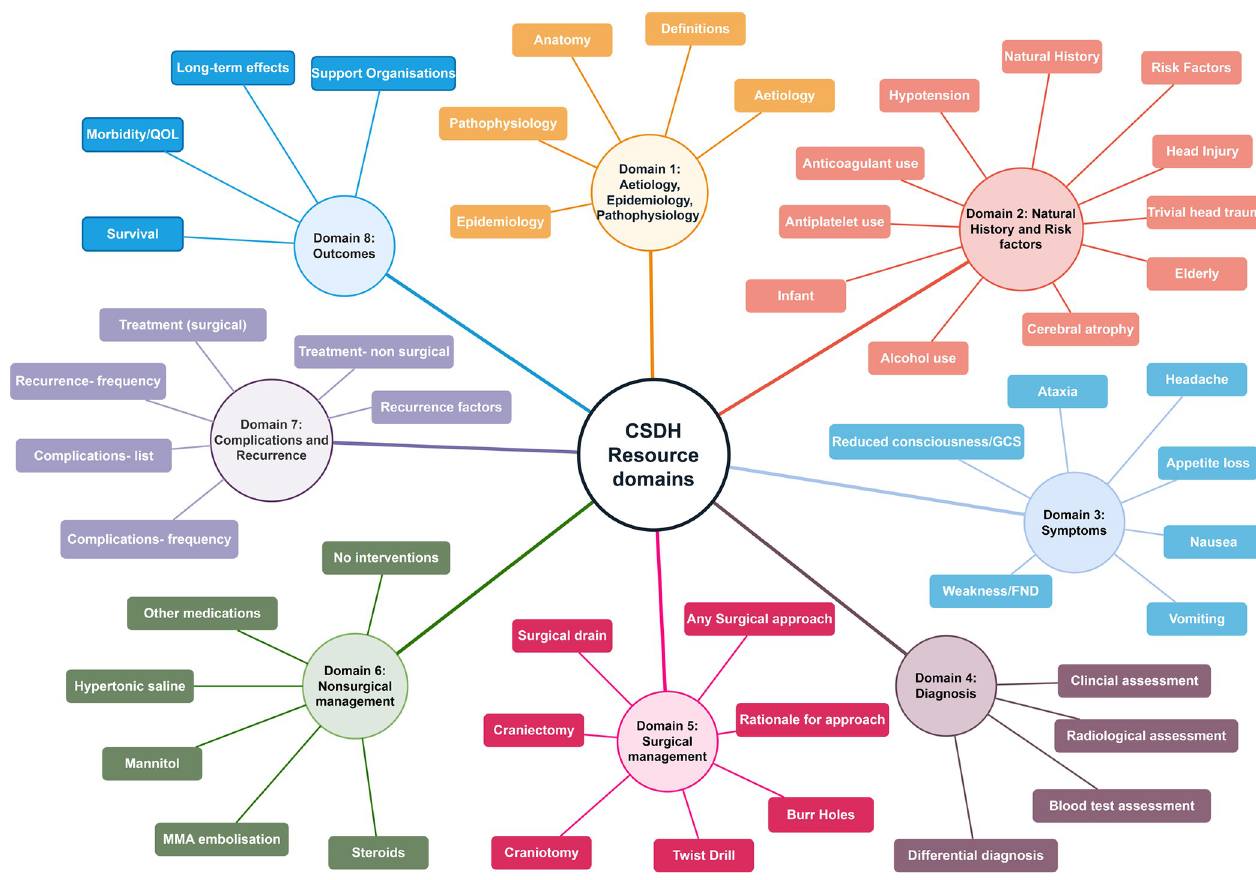
Fig 2. Key education domains for CSDH, devised by inductive thematic